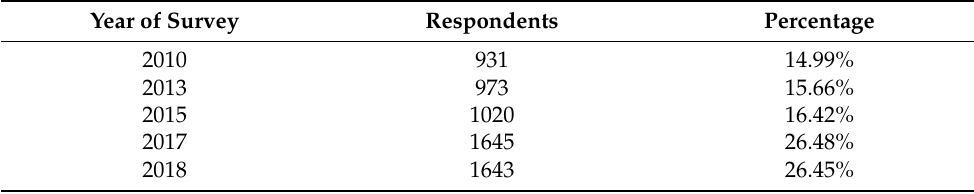
Table 1. Annual distribution of the sample.